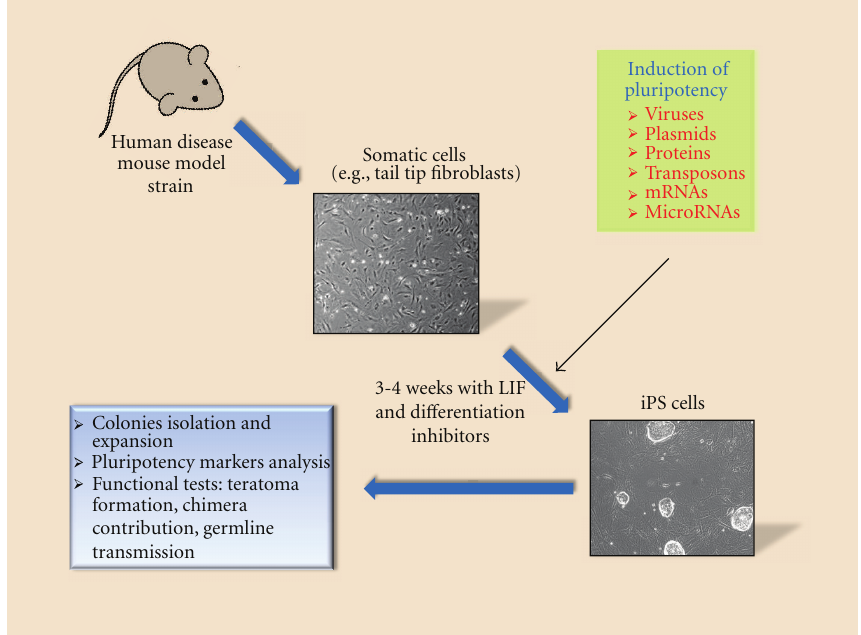
Figure 1: Generation of induced pluripotent stem cells from mouse model somatic